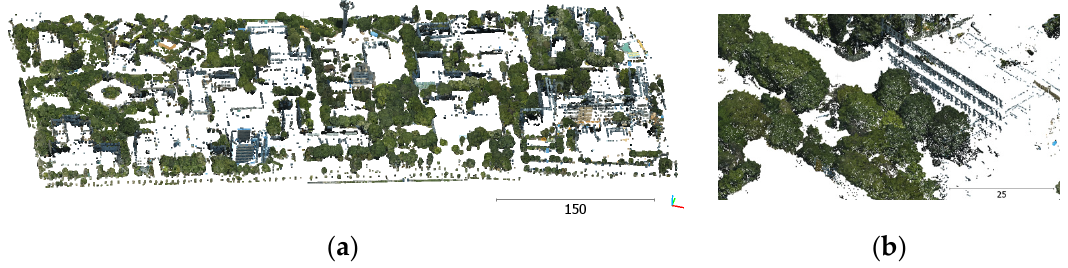
Figure 14. ( a ) Vegetation point cloud extracted using the VDVI attribute, ( b ) detail.